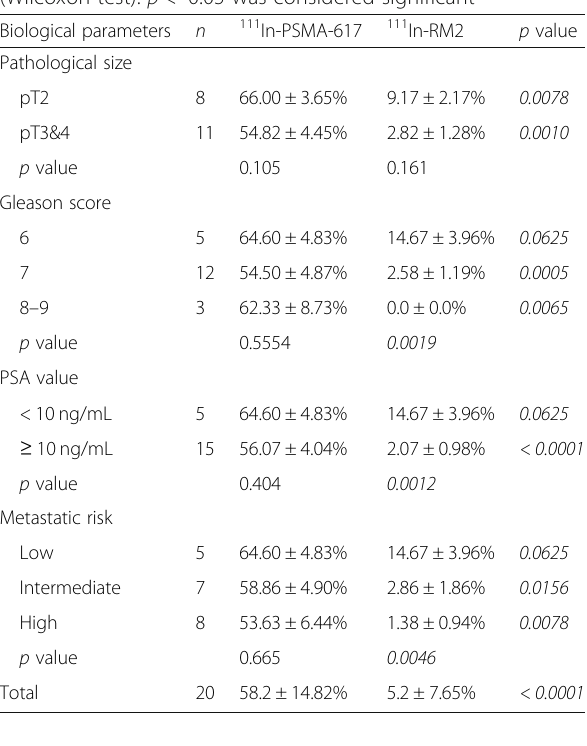
Table 2 Statistical analysis of 111 In-PSMA-617 and 111 In-RM2 bindings according to clinico-biological parameters (pathological size, Gleason score, prostate-specific antigen (PSA) value, and metastatic risk). Non-parametric one-way ANOVA (Kruskal-Wallis test) and non-parametric t test (Wilcoxon test). p < 0.05 was considered significant